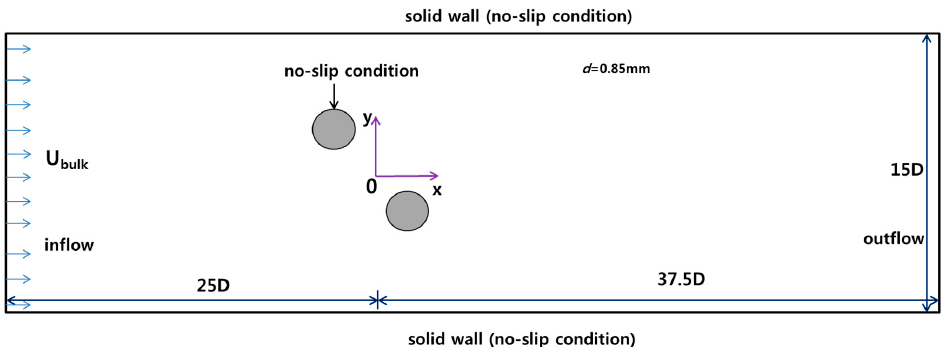
Figure 1. Numerical domain for two cylinders in a staggered array.